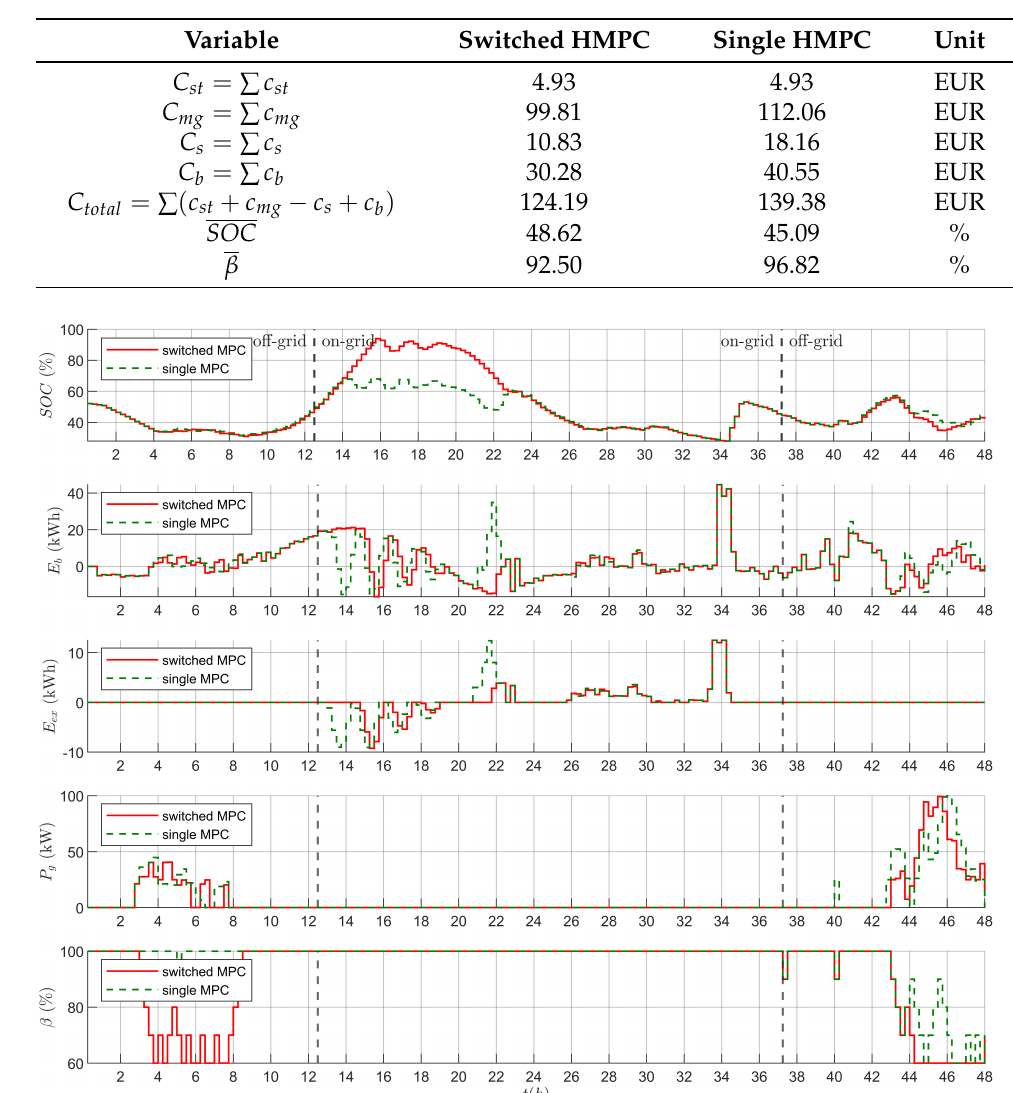
Figure 8. Storage state of charge, energy balance, and all system inputs obtained using switched and single hybrid MPC solutions in the two-day